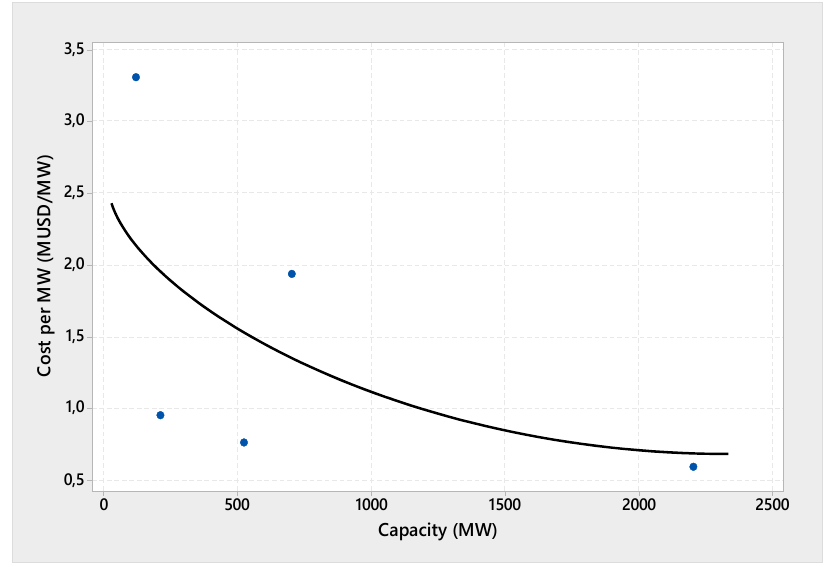
Figure 8. Relation between capacity of existing hydropower plants in Mozambique and their investment cost per MW. Source: own illustration with data from [7,26].